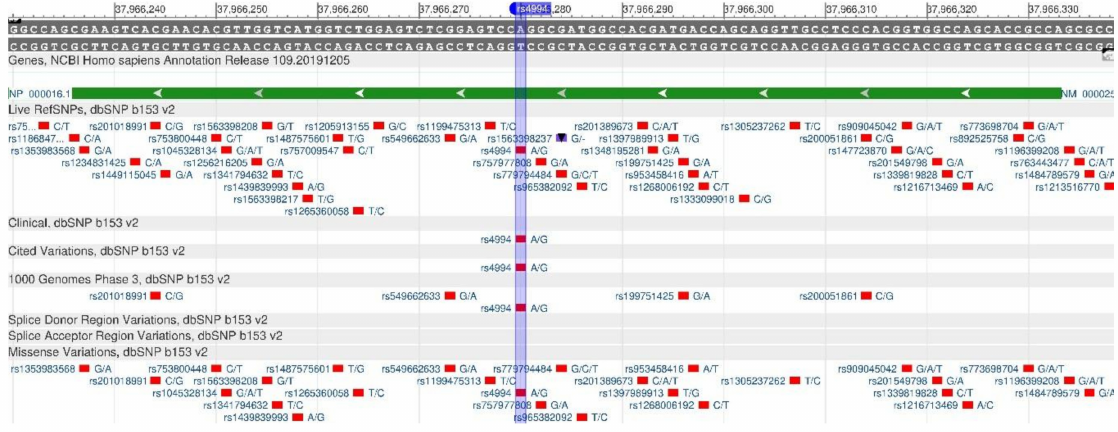
Figure 8. A region of the ADRB3 gene (located on the short (p) arm of chromosome 8) containing the oligonucleotide polymorphism rs4994.